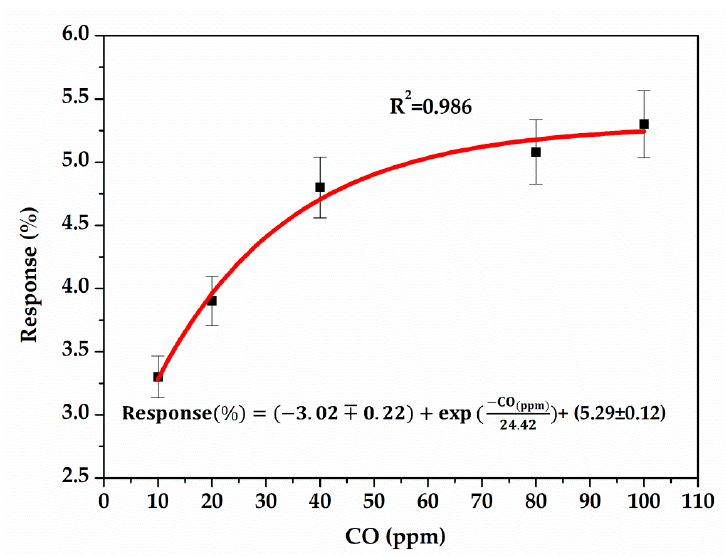
Figure 17. Sensor response versus CO concentration.